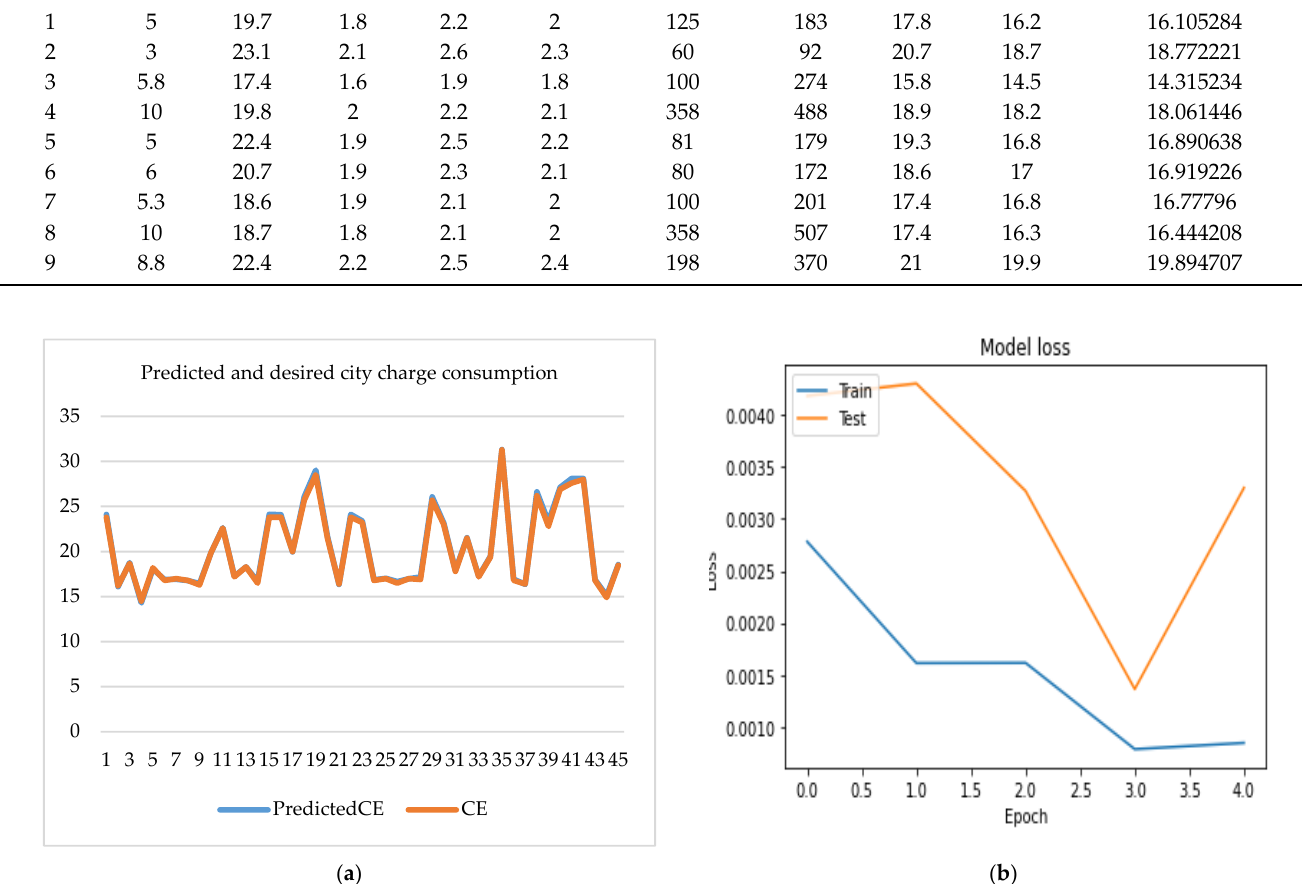
Figure 7. Predicted city electric charge consumption analysis. ( a ) Behaviour of the city electric charge consumption; ( b ) Model loss with increase in epoch.